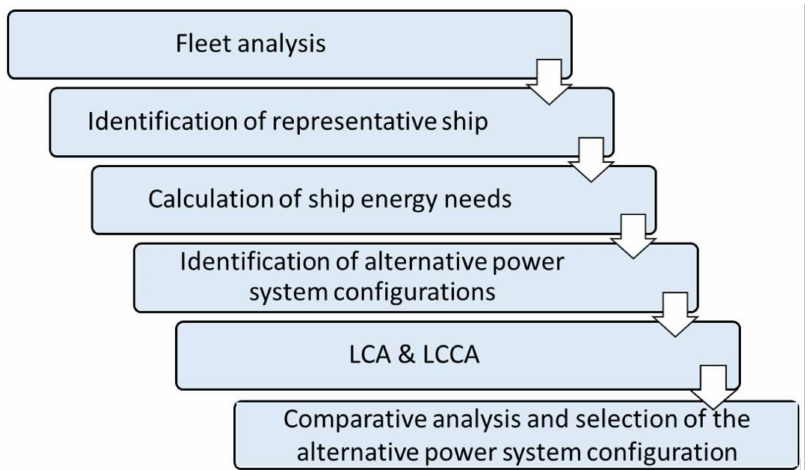
Figure 1. Procedure for the selection of alternative power systems configuration for inland waterway